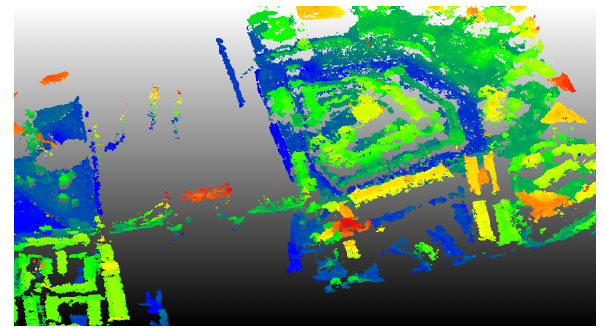
Figure 6. 3D point cloud generated with our pipeline on the PHR London dataset (see section 4.1). On can clearly see the Tower Bridge and Tower of London castle. Note that a water mask has been used over the Tames and nearby